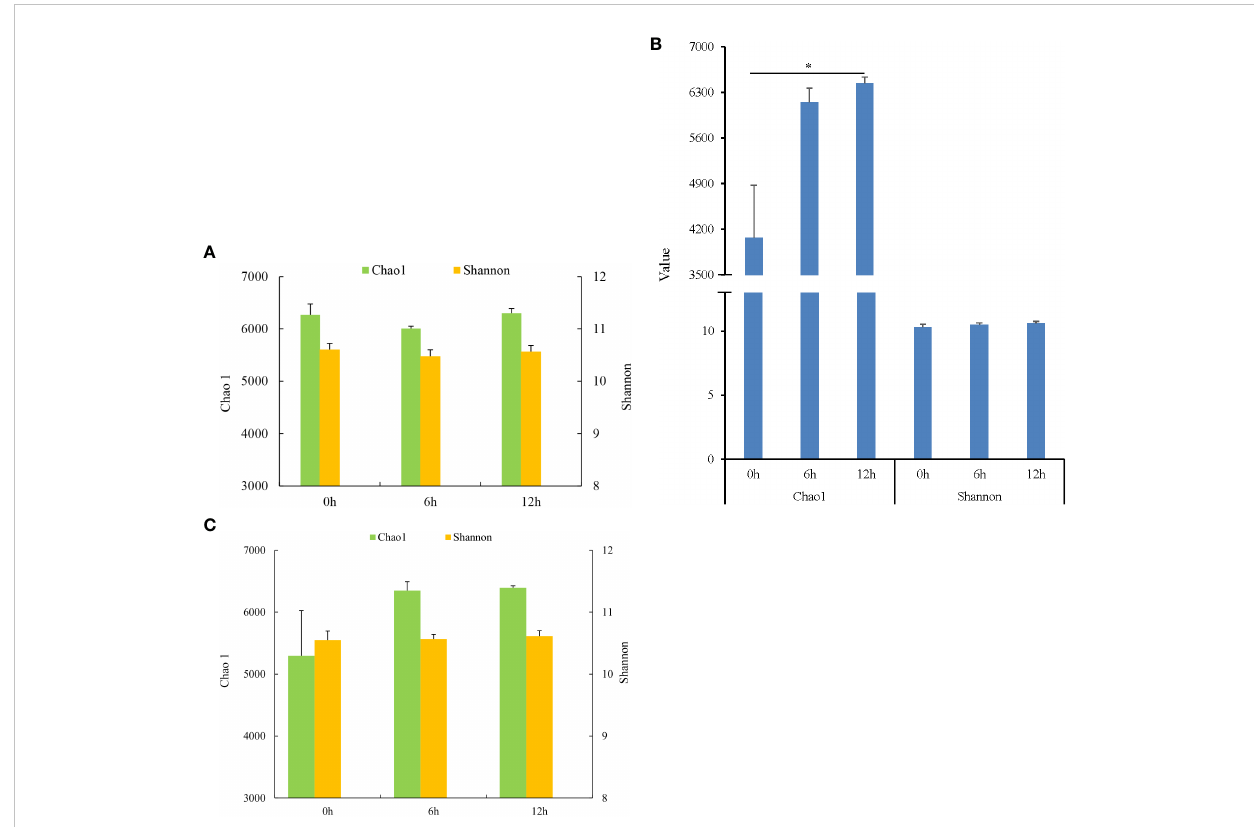
FIGURE 2 Alpha diversities of gastrointestinal microbiota of Japanese fl ounder. (A) stomach; (B) pyloric caecum; (C) gut. * represented that values were signi fi cantly different among different sampling times (n = 3, P <